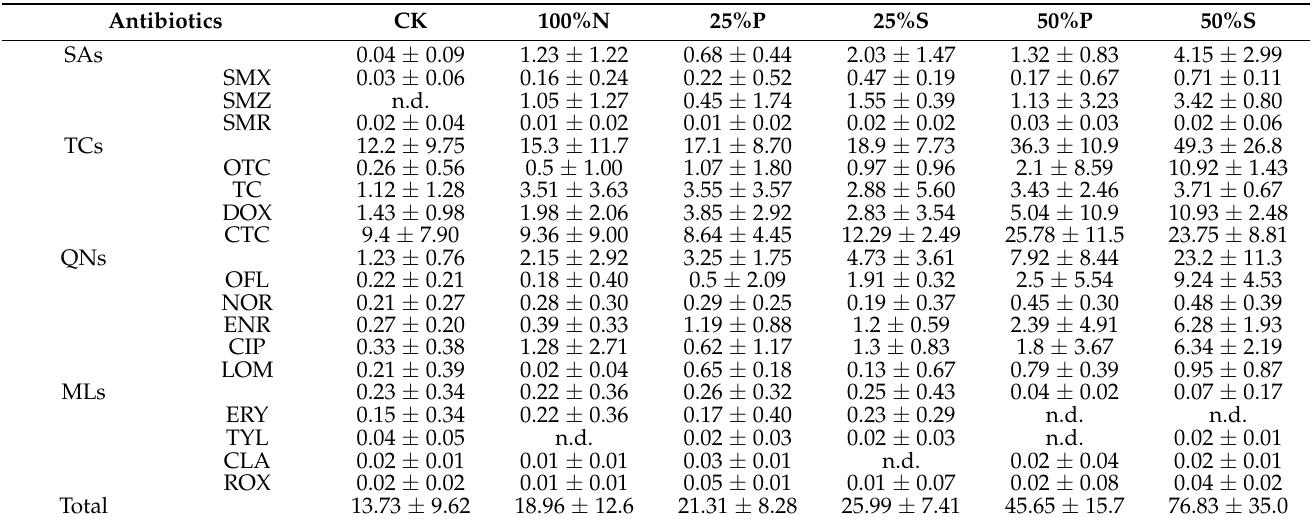
Table 2. Antibiotic residues in soil from different treatments (mean ± standard deviation, ng/g, and dry weight).